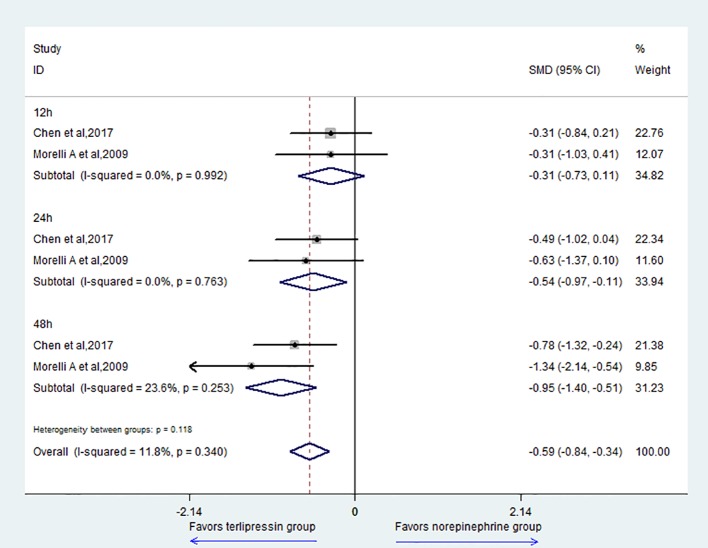
Forest plot of HR.